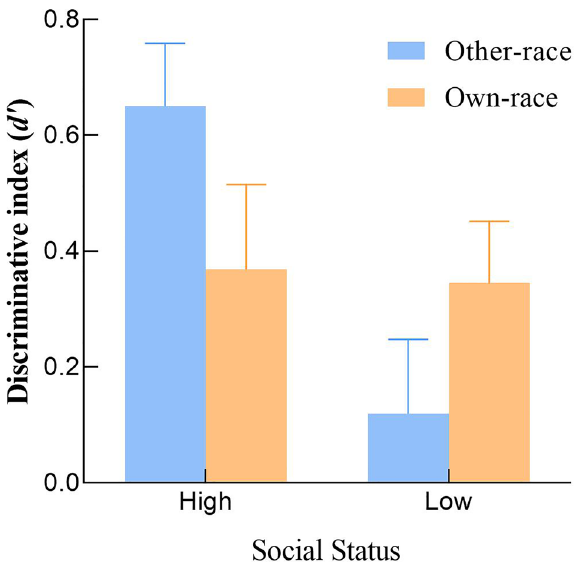
Figure 1. Histogram of the interaction between racial faces and the mean discriminative index ( d ′ ) of social status in Study 1. Error bars: ±